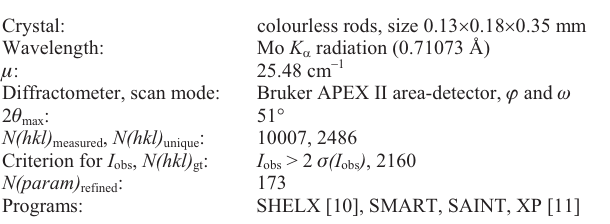
Table 1. Data collection and handling.